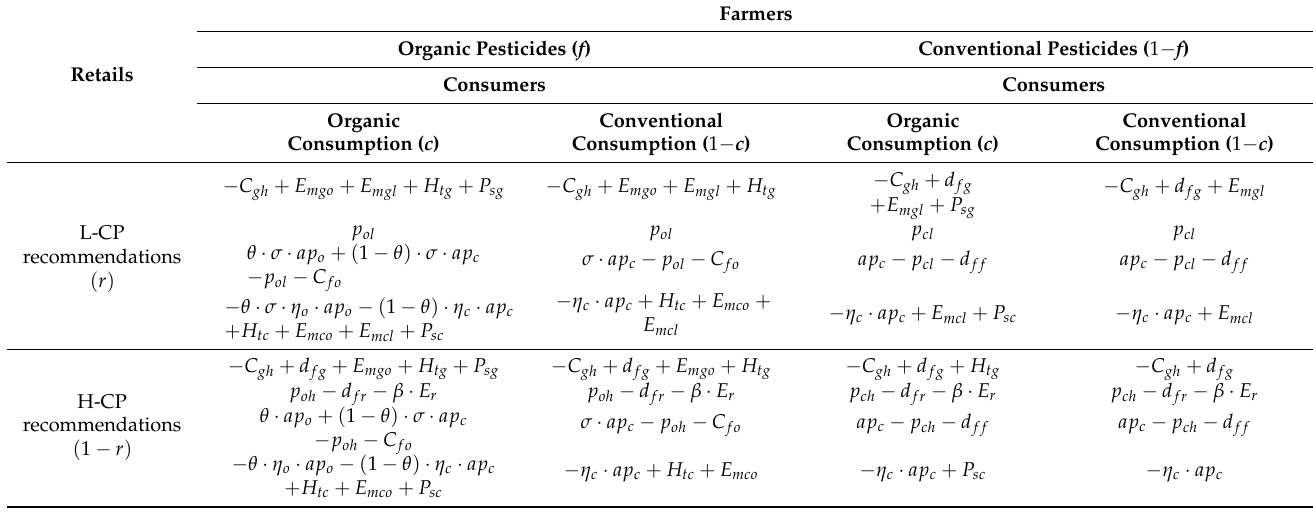
Table 2. Quadrilateral evolutionary game payoff matrix when local governments choose strict regulation ( g